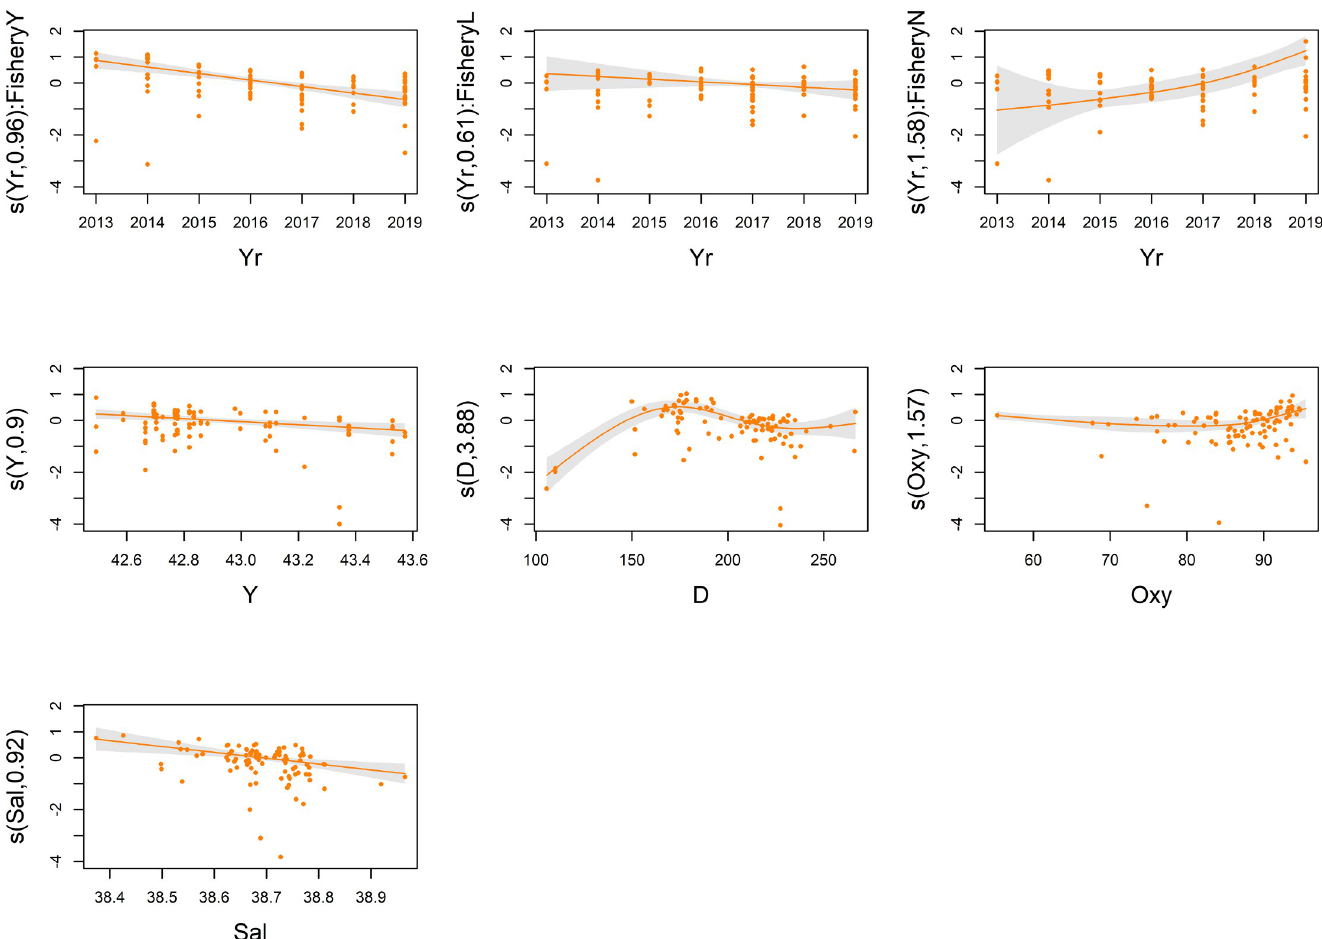
Fig 2. Partial effects plots of GAM on Nephrops CPUE (kg/km 2 ). Partial effects (y axis) of spatial (Y, D), environmental (Oxy, Sal), and fishery management variables (Yr:Fishery) selected for the final GAM. Grey shaded regions indicate the 95% confidence intervals, dots are the